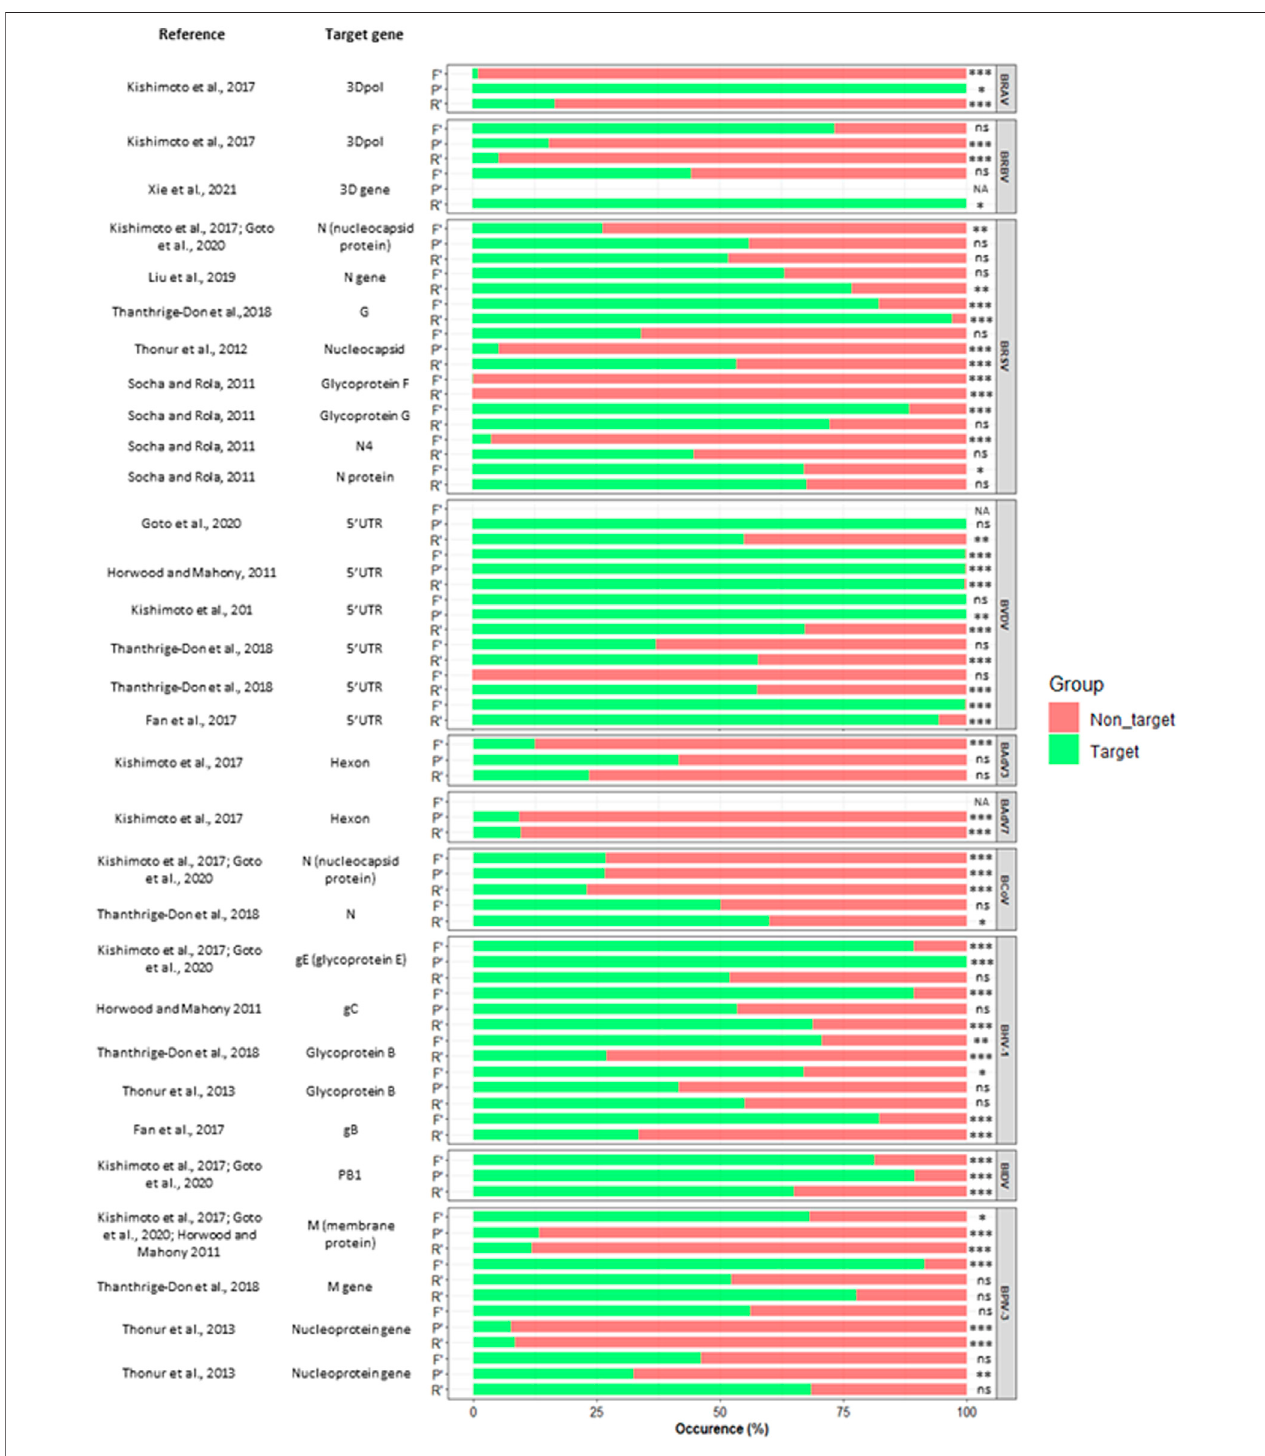
FIGURE 2 | Occurrence of target and non-target sequence alignment for published primer and probe sequences targeting the respiratory disease-causing viral pathogens in cattle. Bovine coronavirus (BCoV), Bovine herpesvirus 1 (BHV-1), Bovine rhinitis A virus (BRAV), Bovine rhinitis B virus (BRBV), Bovine respiratory syncytial virus (BRSV) Bovine in fl uenza D virus (BIDV) Bovine viral diarrhea virus (BVDV), Bovine parain fl uenza virus 3 (BPIV-3), and Fisher ’ s exact test; p > 0.05 ns, p ≤ 0.05 *, p ≤ 0.01 **, p ≤ 0.001 ***.